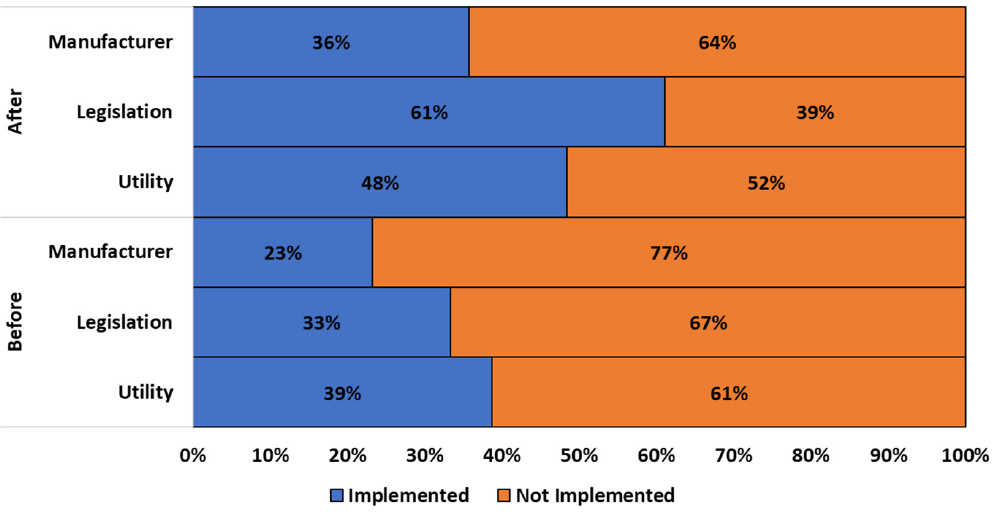
Figure 6. Changes in implementation according to the scenario group.